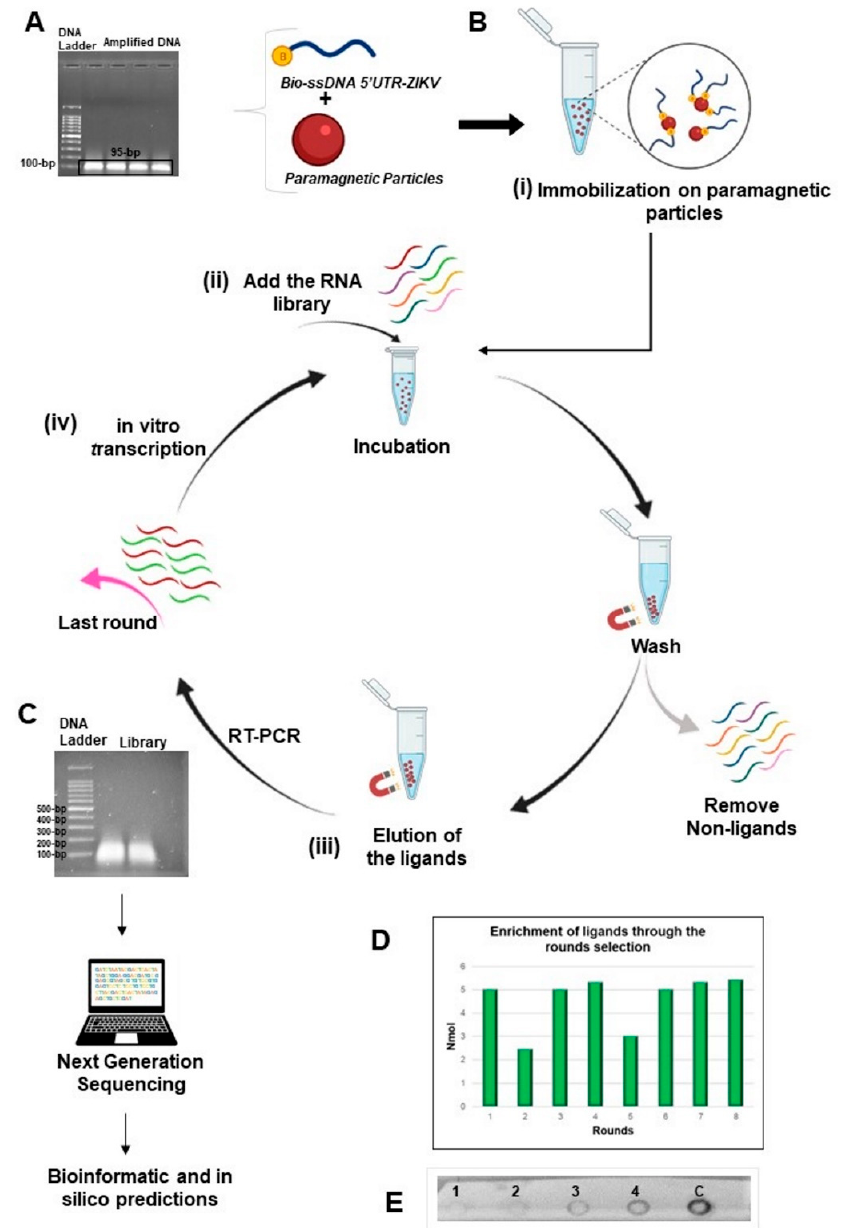
Figure 1. Representation of the method SELEX used in this study. ( A ) Electrophoresis agarose gel of the product of the ZIKV as target obtained from the 5’UTR synthetic sequence and presenting an expected size of 95-bp; ( B ) Steps for the selection process: ( i ) by using the biotinylated target immobilized on paramagnetic particles recovered with streptavidin; ( ii ) RNA library of ligands was added for incubation and the non-ligand oligonucleotides were removed; ( iii ) the binding molecules were eluted and amplified by RT-PCR; ( iv ) in vitro transcription of the amplified products initiated a new round for enrichment of RNA ligands; ( C ) Last round of ligand selection was analyzed by electrophoresis and then submitted to the next generation of sequencing (NGS). The oligonucleotides presented fragments with approximate size from 50 to 250-bp; ( D ) Enrichment of the ligands post-rounds of selection. The products of each round were quantified after in vitro transcriptions with a similar amount of the recovered products, except for the second and fifth rounds; ( E ) Hybridization by dot-blot assay demonstrating the enrichment and affinity of the ligands from the 2nd round (1st dot), 4th round (2nd dot), 6th round (3rd dot), 8th round (4th dot), and the dsDNA from 5’UTR-ZIKV as a positive control of the probe (5th dot). This figure was created through BioRender.com.